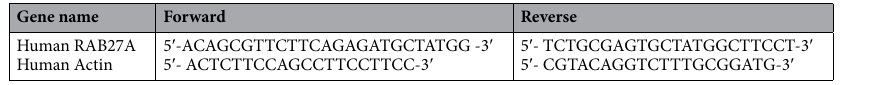
Table 1. The primers used to amplify cDNA in Real-Time PCR.